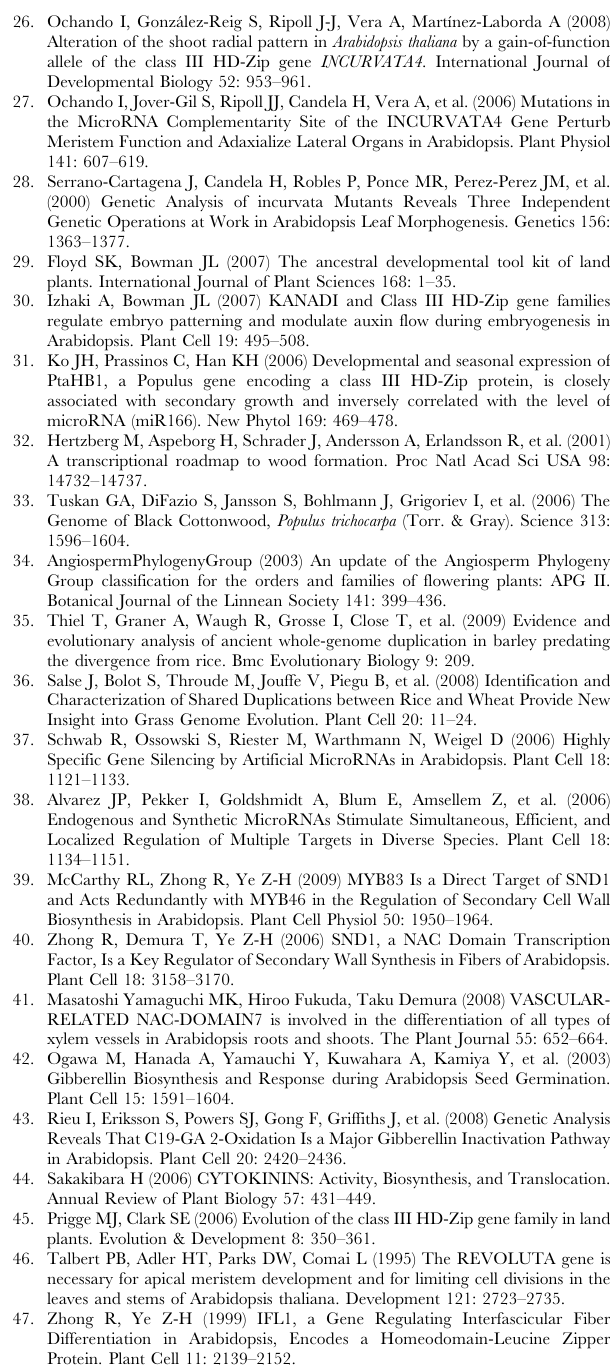
Table S3 Output from microarray analysis at the level of P. trichocarpa gene models, excluding probes designed against Populus spp. ESTs.